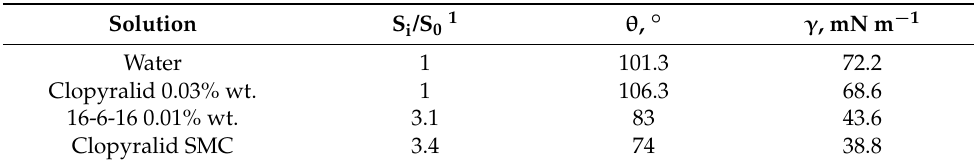
Table 2. Surface properties of clopyralid and hexanediyl-1,6-bis(dimethylcetylammonium bromide) (16-6-16) solutions: spreading area (S), contact angle ( θ ) and surface tension ( γ ).